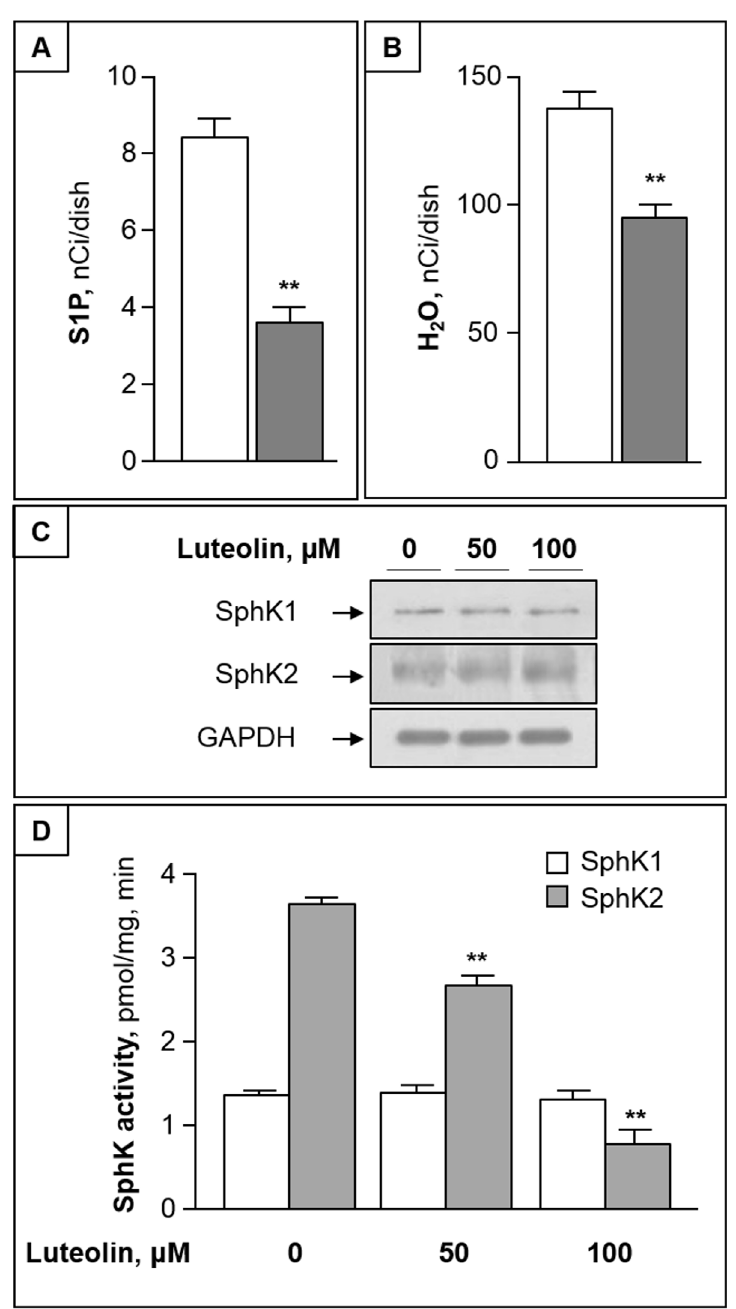
Fig 5. Luteolin reduces cellular S1P by inhibiting SphK2. (A) and (B) CC cells were pulsed with 3 H-Sph for 2 h in the absence (white bar) or presence of 100 μ M luteolin (grey bar). At the end, labeled S1P (A) and water (B) were evaluated in cells and medium, respectively. (C) CC cells were treated with 50 – 100 μ M luteolin for 2h, and equal amounts of proteins were then analyzed for SphK1 and SphK2 proteins by immunoblotting. GAPDH was used as loading control. (D) SphK1 and SphK2 activities were assayed in the absence or presence of luteolin, using CC cell homogenate as enzyme source. Data are mean ± S.D. of three experiments in duplicate. ** , p < 0.01 vs.